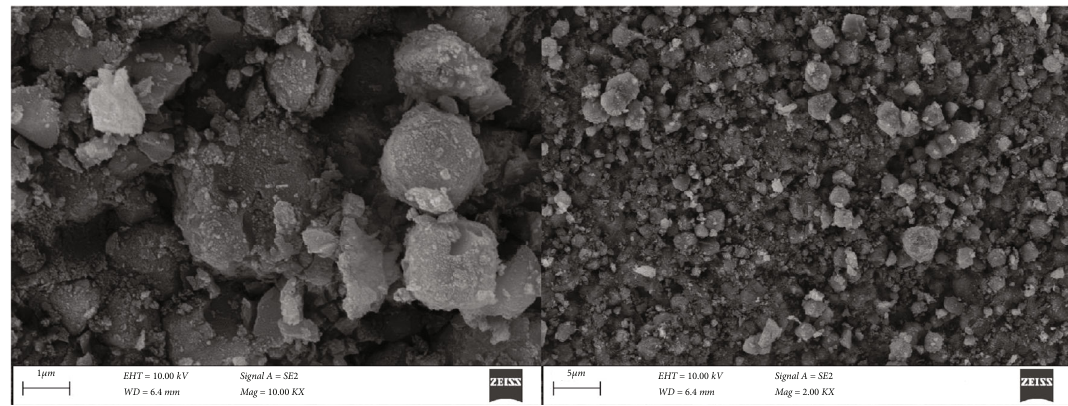
Figure 4: SEM images of zeolite